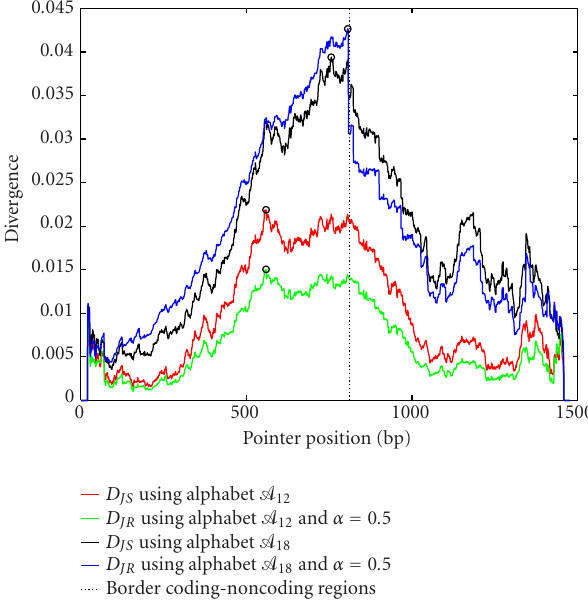
Figure 10: Jensen-Shannon divergence and Jensen-R´enyi diver- gence versus cutting position for a DNA sequence containing a cod- ing region followed by a noncoding region. The maximum values for the divergences are circled on the graph.